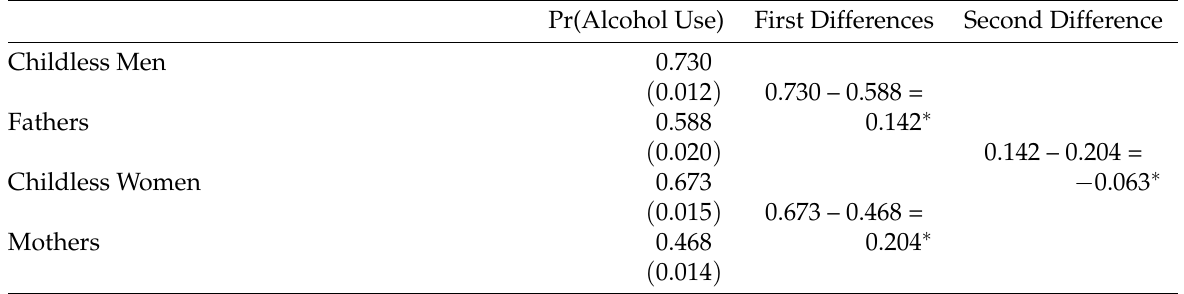
Figure 12: Probability of alcohol use by gender and parental status. Table 3: Probability of alcohol use by gender and parental status with test of interaction Eeffect ( N = 4,